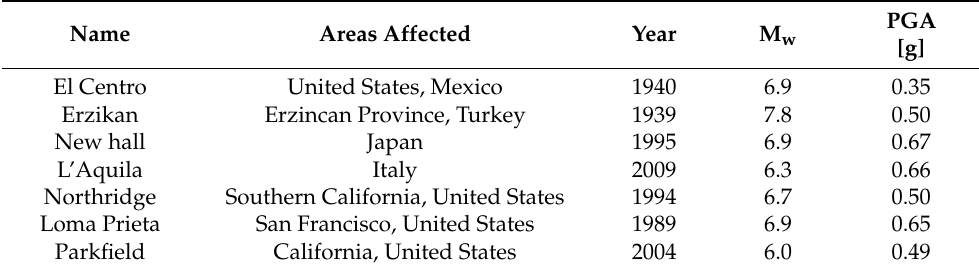
Table 6. List of the earthquake selected for the incremental dynamic